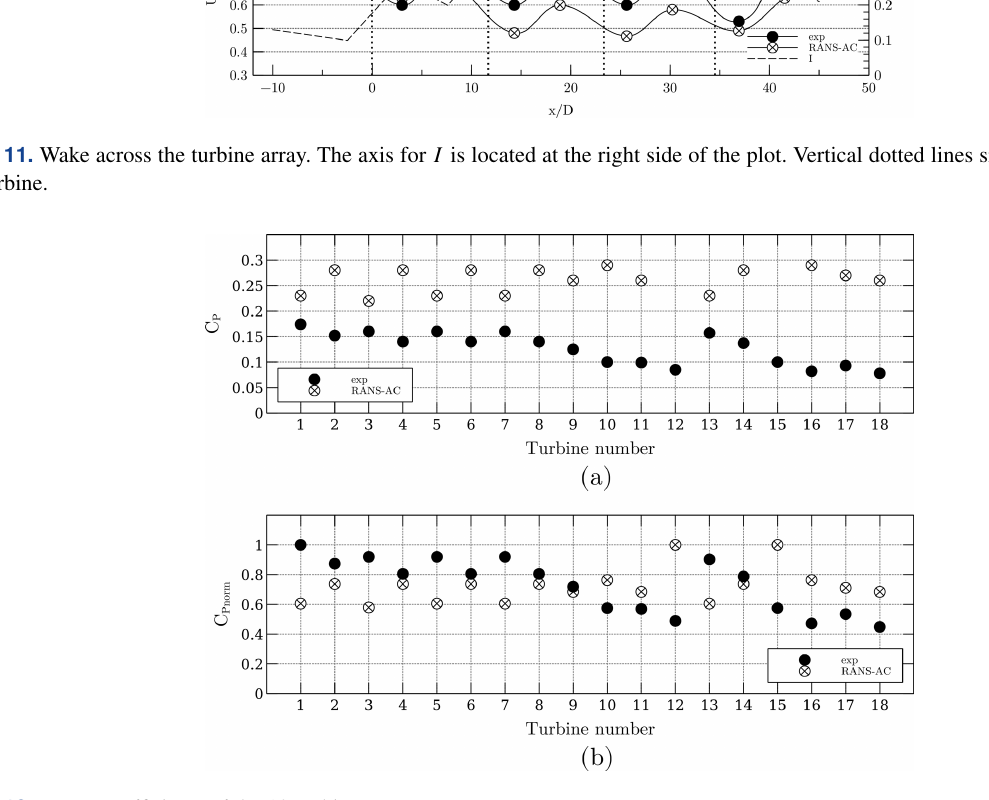
Figure 12. Power coefficients of the 18-turbine